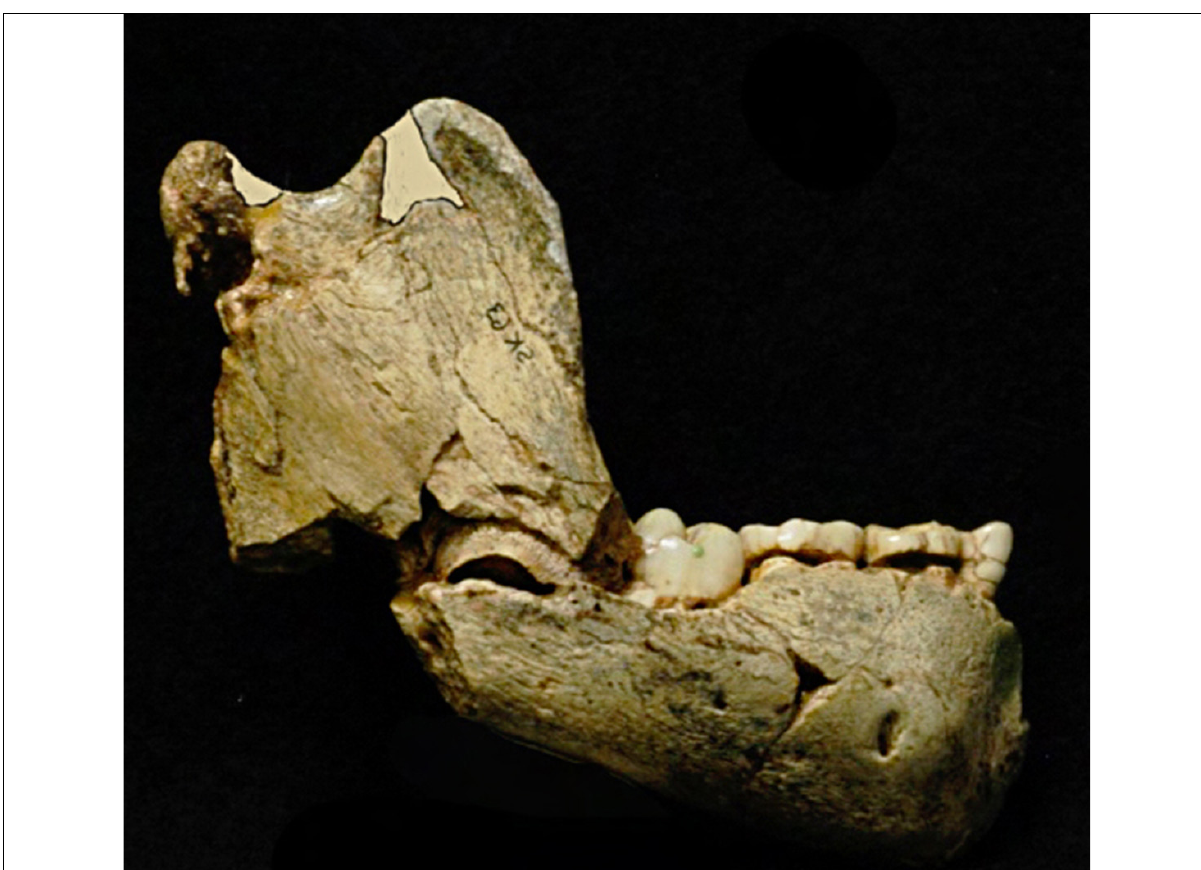
Figure 4: A juvenile Au. robustus specimen, SK 63 (flipped), exhibiting the ramal configuration typical of Australopithecus .